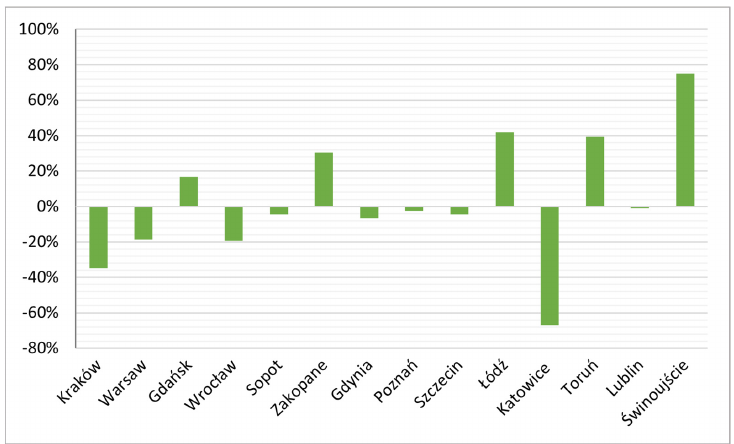
Figure 4. Index of dynamics of changes from Q1 2019 to Q4 2021. (Q means quarter).